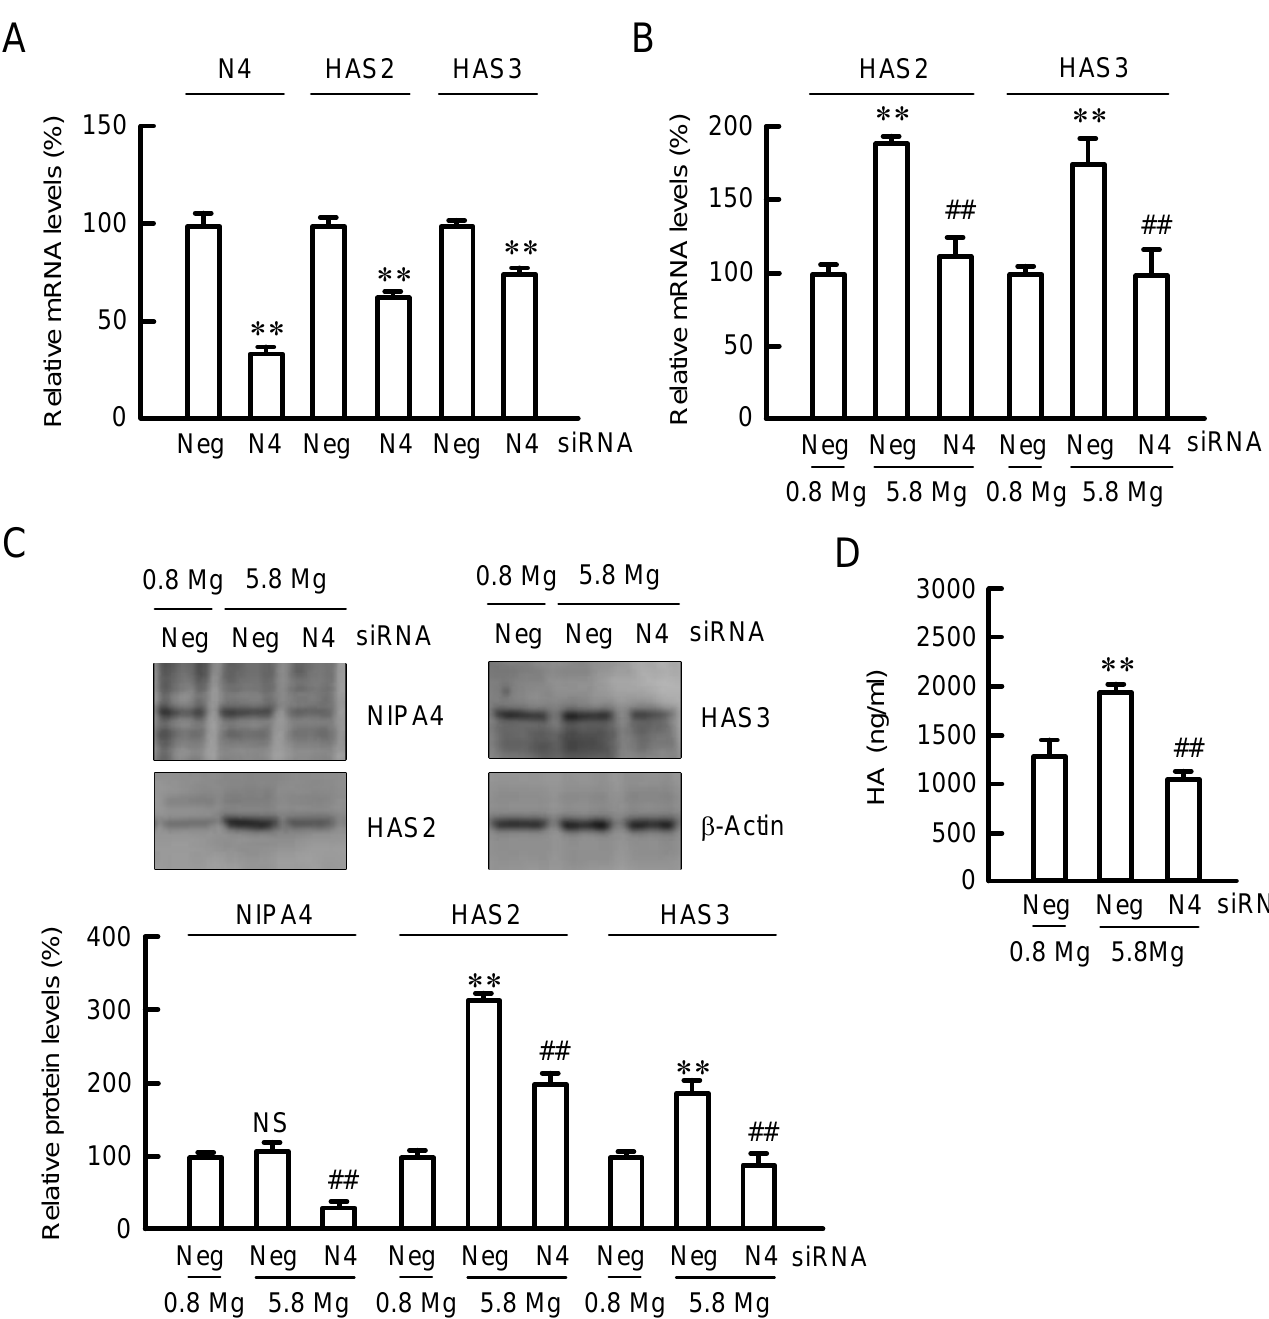
Figure 2. Effect of NIPAL4 siRNA on HAS2/3 expressions. Cells were transfected with negative (Neg) or NIAPL4 (N4) siRNA. ( A ) After transfection, the cells were incubated in the presence of 0.8 mM MgCl 2 for 72 h. The mRNA levels of N4 and HAS2/3 were measured by real-time PCR analysis and represented as a percentage of negative siRNA. ( B ) After 66 h of transfection, the cells were incubated in the presence of 0.8 and 5.8 mM MgCl 2 for 6 h. The mRNA levels of HAS2/3 were measured by real-time PCR analysis and represented as a percentage of 0.8 mM MgCl 2 . ( C , D ) After 48 h of transfection, the cells were incubated in the presence of 0.8 and 5.8 mM MgCl 2 for 24 h. The protein levels of NIPA4 and HAS2/3 were measured by Western blotting analysis and represented as a percentage of 0.8 mM MgCl 2 . HA contents in the media were measured using a Hyaluronan Quantification kit. n = 3–4. ** p < 0.01 significantly different from negative siRNA or 0.8 mM MgCl 2 . NS p > 0.05. ## p < 0.01 significantly different from negative siRNA plus 5.8 mM MgCl 2 .